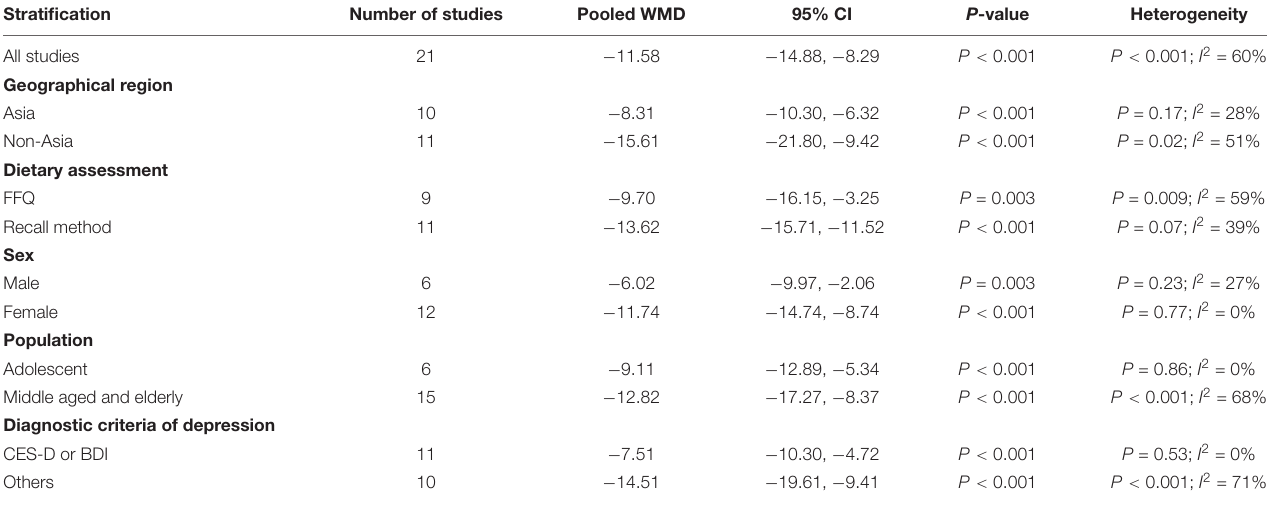
TABLE 3 | Subgroup analysis for WMD of dietary vitamin C level in depression versus control